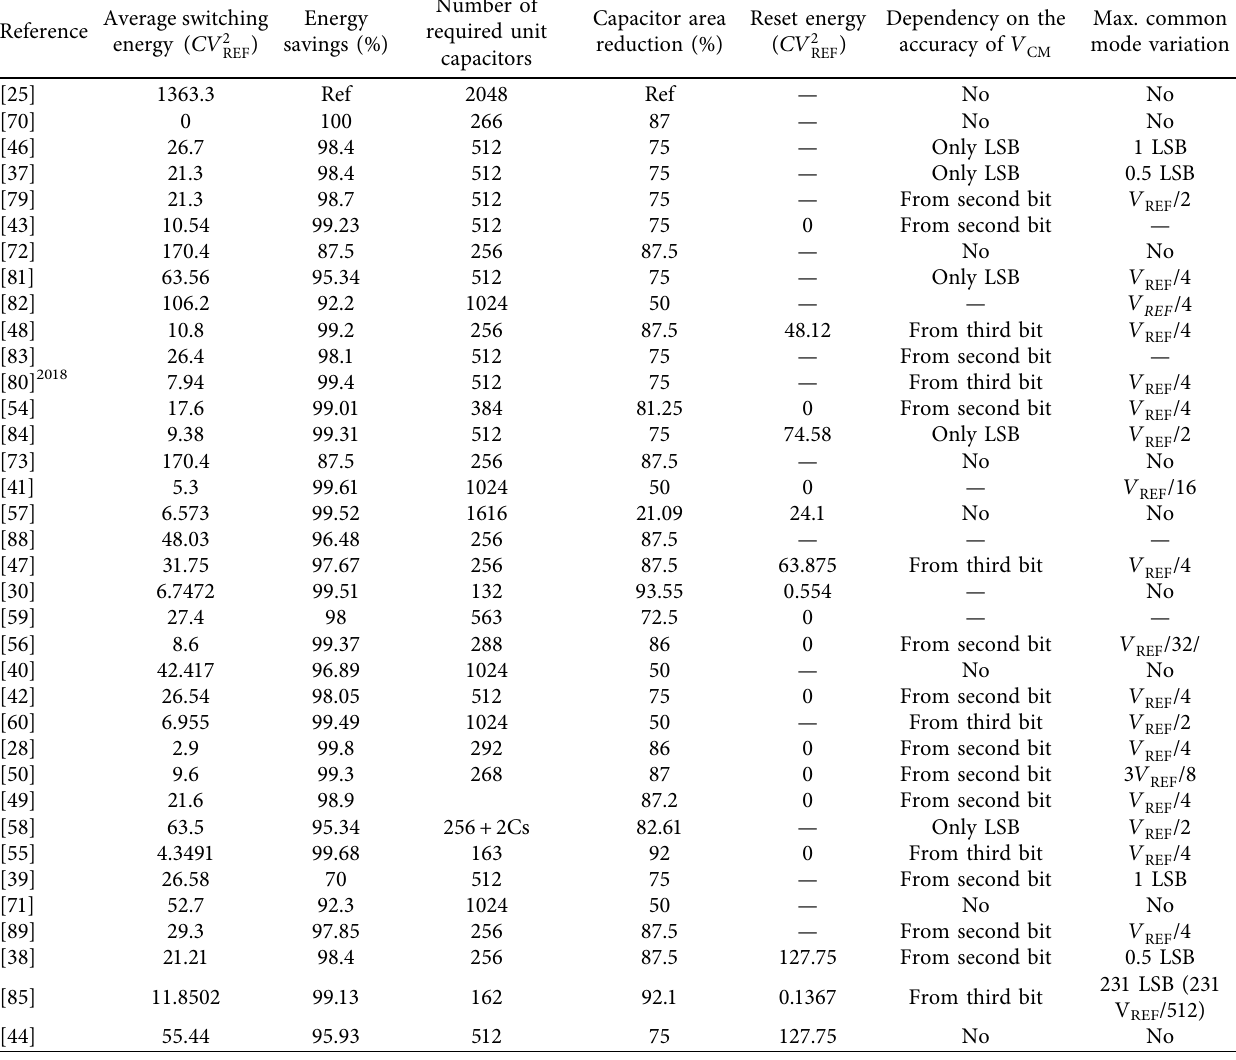
Table 9: Performance summary of energy-efcient in DAC with MATLAB.